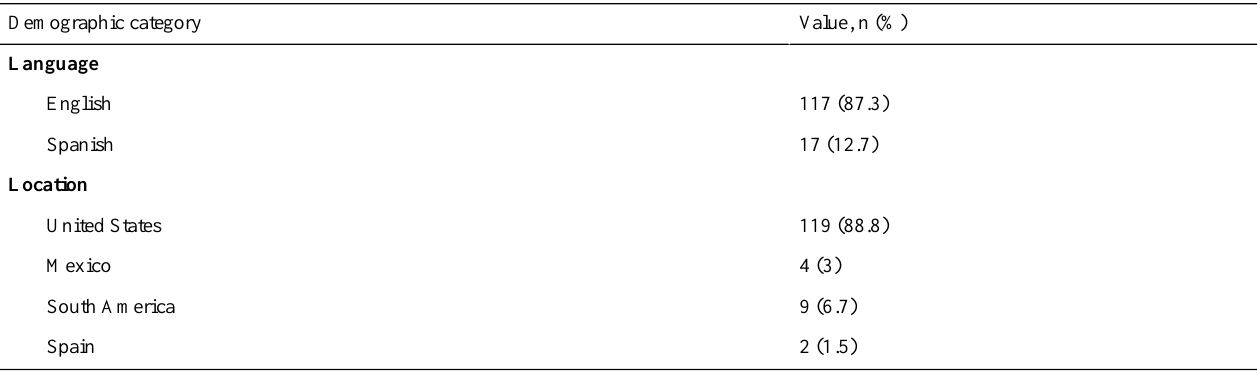
Table 1. Demographic data of Amazon Mechanical Turk participants